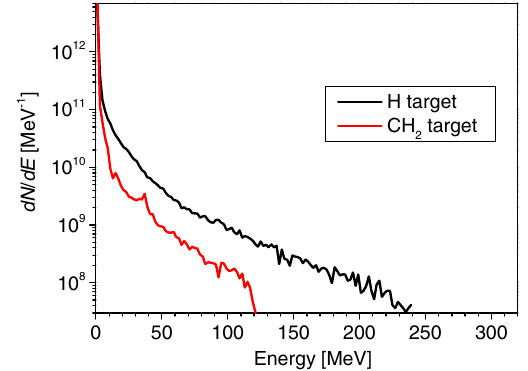
FIG. 9. Proton energy distributions calculated through PIC numerical simulations for different targets with a thickness of 5 μ m and for a laser intensity of ∼ 6 × 10 21 W = cm 2 a low-density solid-H target can reach values of about 25%.